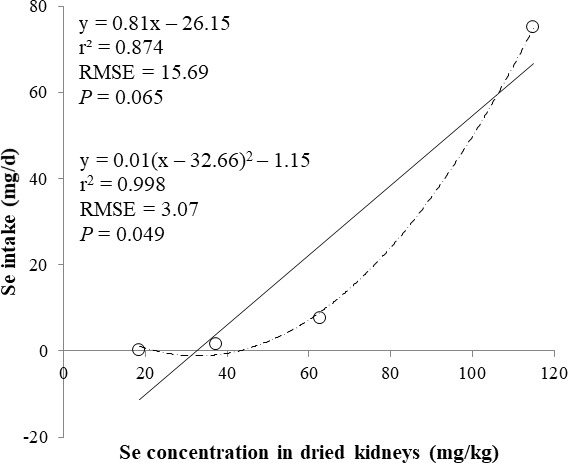
Linear regression equation for estimating daily selenium (Se) intake (mg/d) based on the Se concentration in dried kidneys (mg/kg).Each data point represents least squares mean of four observations. r2, coefficient of determination; RMSE, root mean square of error.